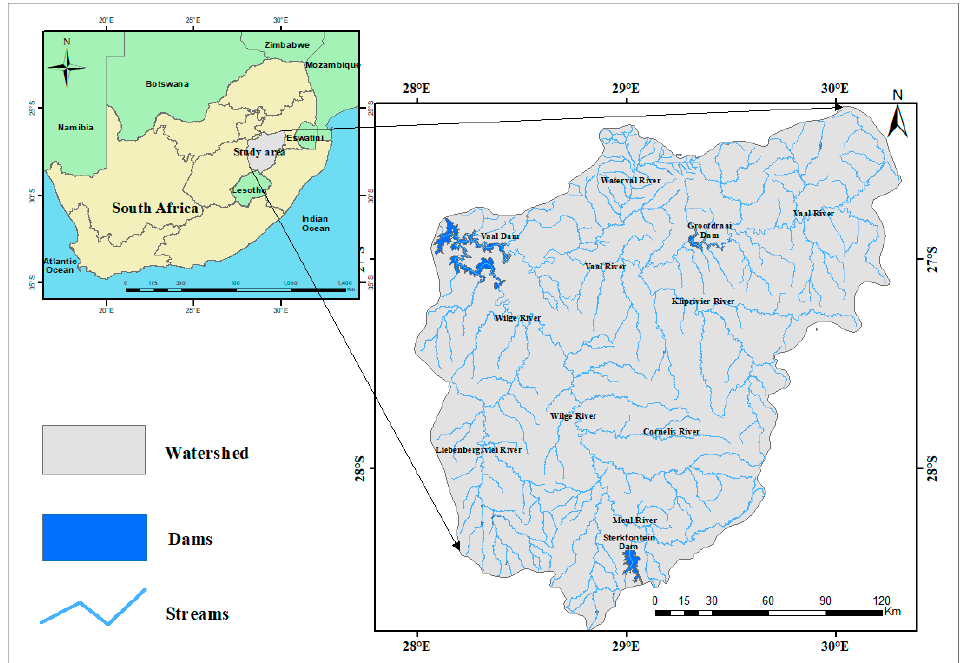
Figure 1. The location map of the study area.